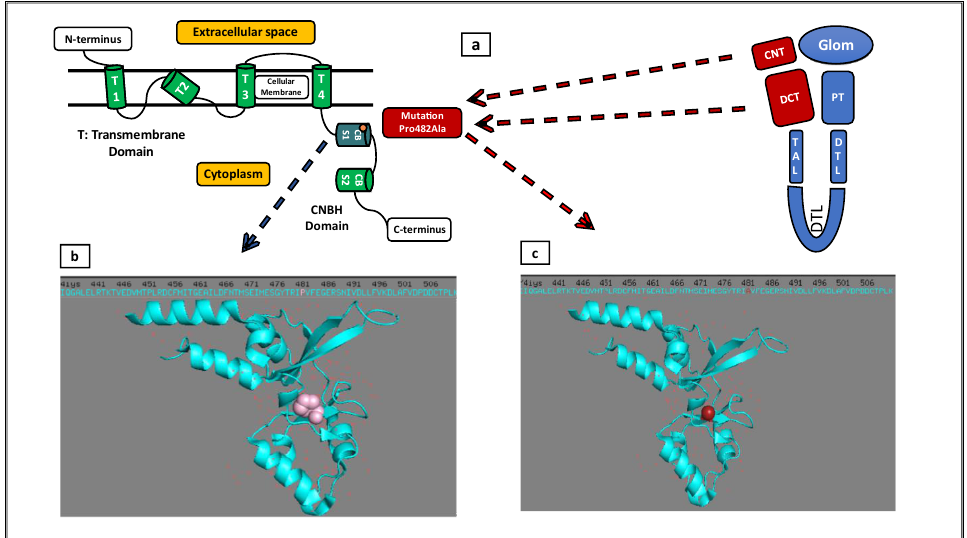
Figure 2. ( a ) Normal localization of CNNM2 (red color) within nephron segments (Glom: Glomer- ulus, PT: Proximal Tubule, DTL: Descending Thin Limb of Loop of Henle, TAL: Thick Ascending